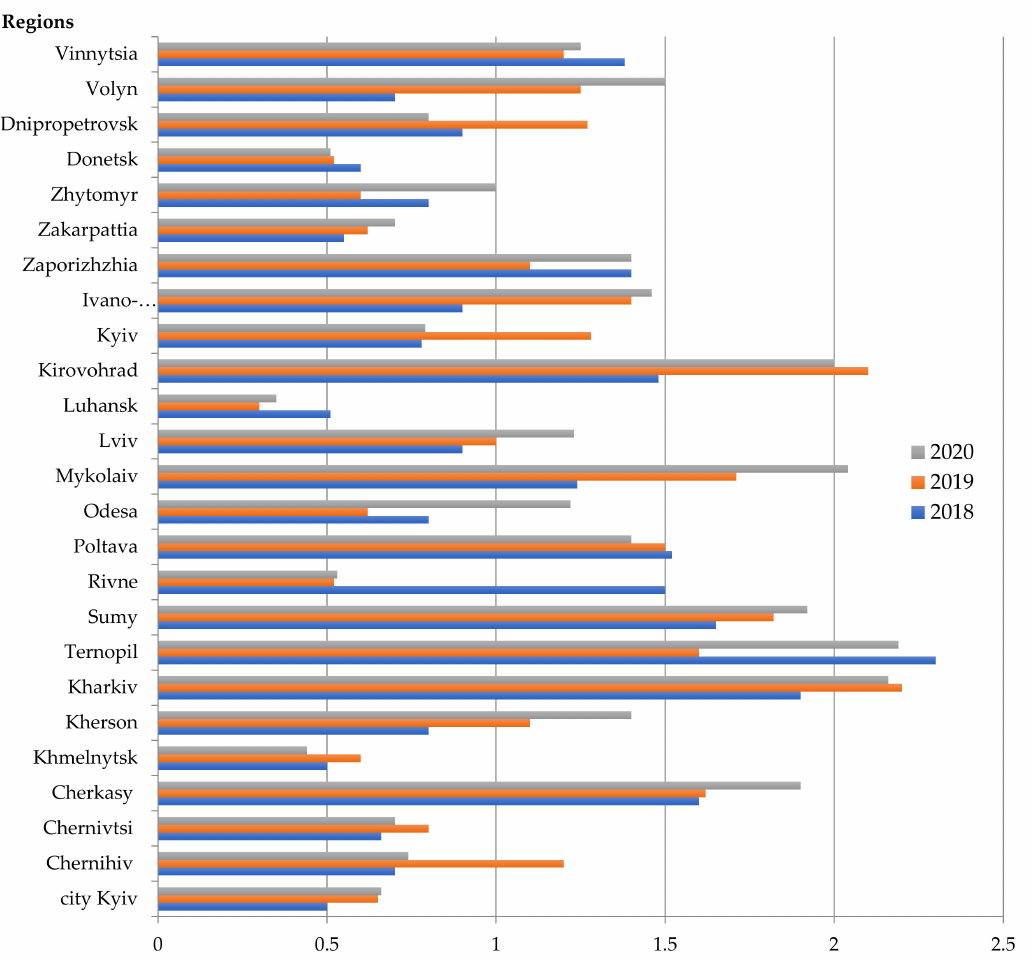
Figure 5. The share of innovation-active enterprises in the total number of industrial enterprises by region at the beginning of 2021, % [33].